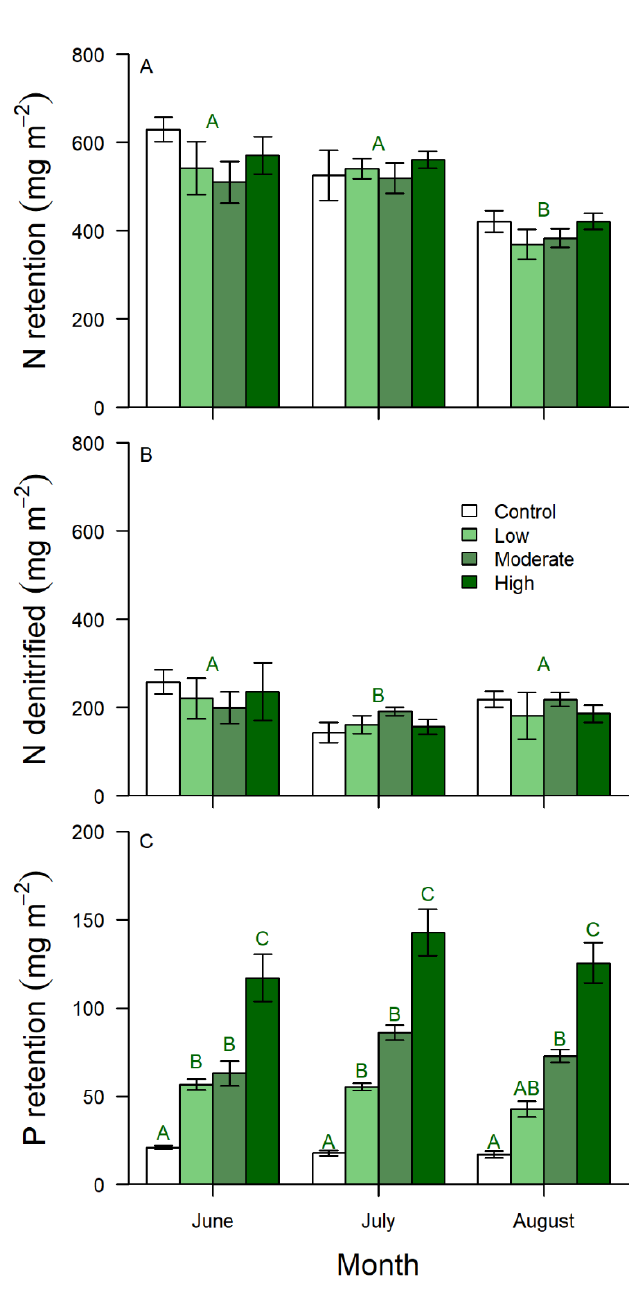
Figure 2. Mean (± SE) N retention ( A ), denitrification ( B ), and P retention ( C ) across three different months from mesocosms representing different P enrichment treatments. Letters represent significant differences between treatments based on least-square mean post-hoc tests ( p < 0.05).